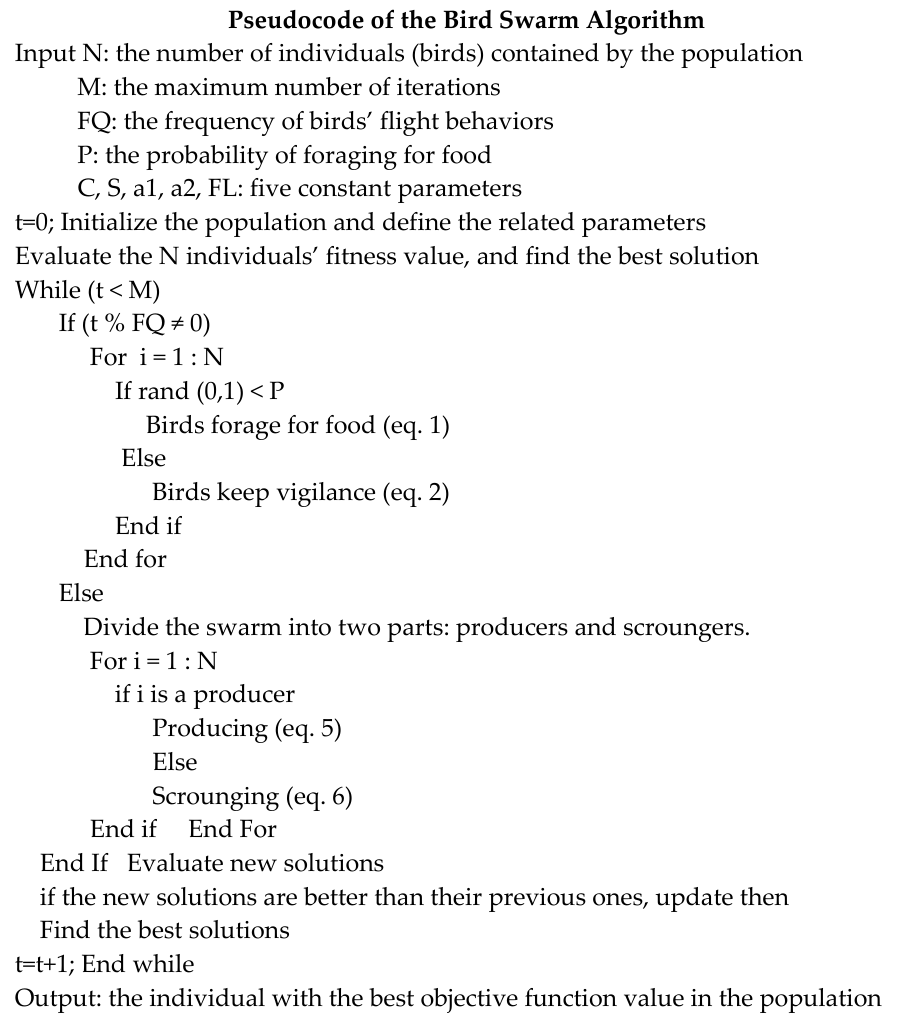
Pseudocode of the Bird Swarm Algorithm